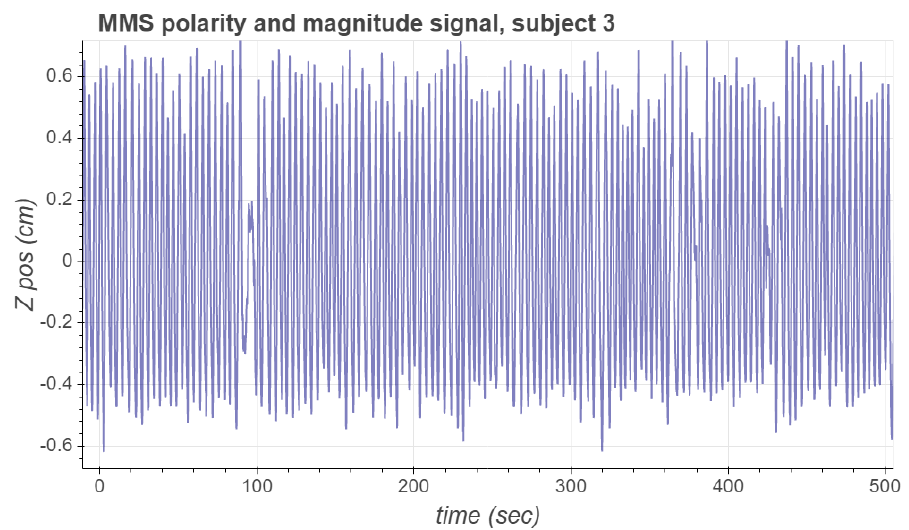
Figure 4. MMS polarity and magnitude signal for subject